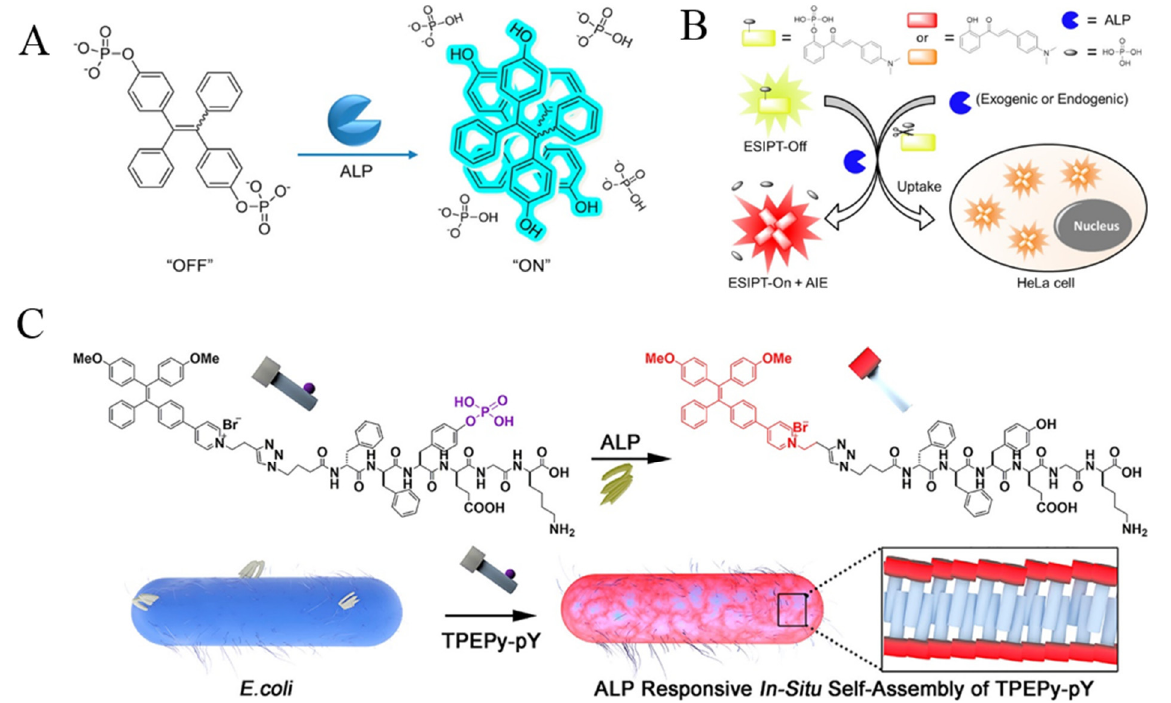
Figure 6. ( A ) Illustration of the design principles of ALP assay with a TPE-2PA probe. Reprinted with permission from ref. [59]. Copyright 2013, American Chemical Society. ( B ) Schematic illustration of HCAP for ALP activity assay in solution and in living cells. Reprinted with permission from ref. [63]. Copyright 2014, American Chemical Society. ( C ) Schematic illustration of the peptide self-assembly-controlled turn-on probe for sensing ALP activity. Reprinted with permission from ref. [65]. Copyright 2020, American Chemical Society.